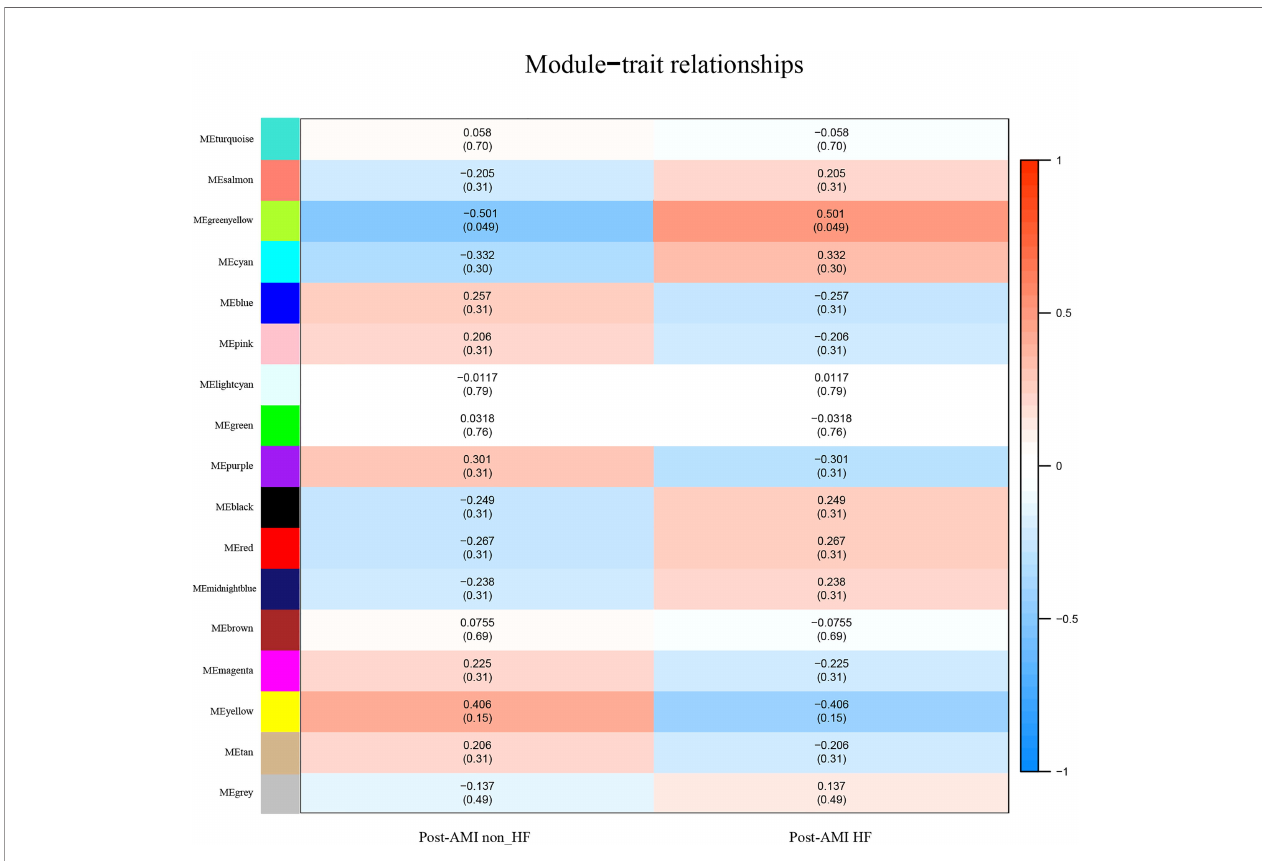
FIGURE 2 | Identi fi cation of highly correlated modules of post-AMI HF. Heatmap of the association between module eigengenes and HF progression after AMI. The correlation coef fi cient (cor) and Q-value are presented in each cell. The greenyellow module was found to be signi fi cantly correlated with post-AMI HF according to | cor|>0.5 and Q-value < 0.05. Red indicates a positive correlation between two modules, and blue indicates a negative correlation. AMI, acute myocardial infarction; HF, heart